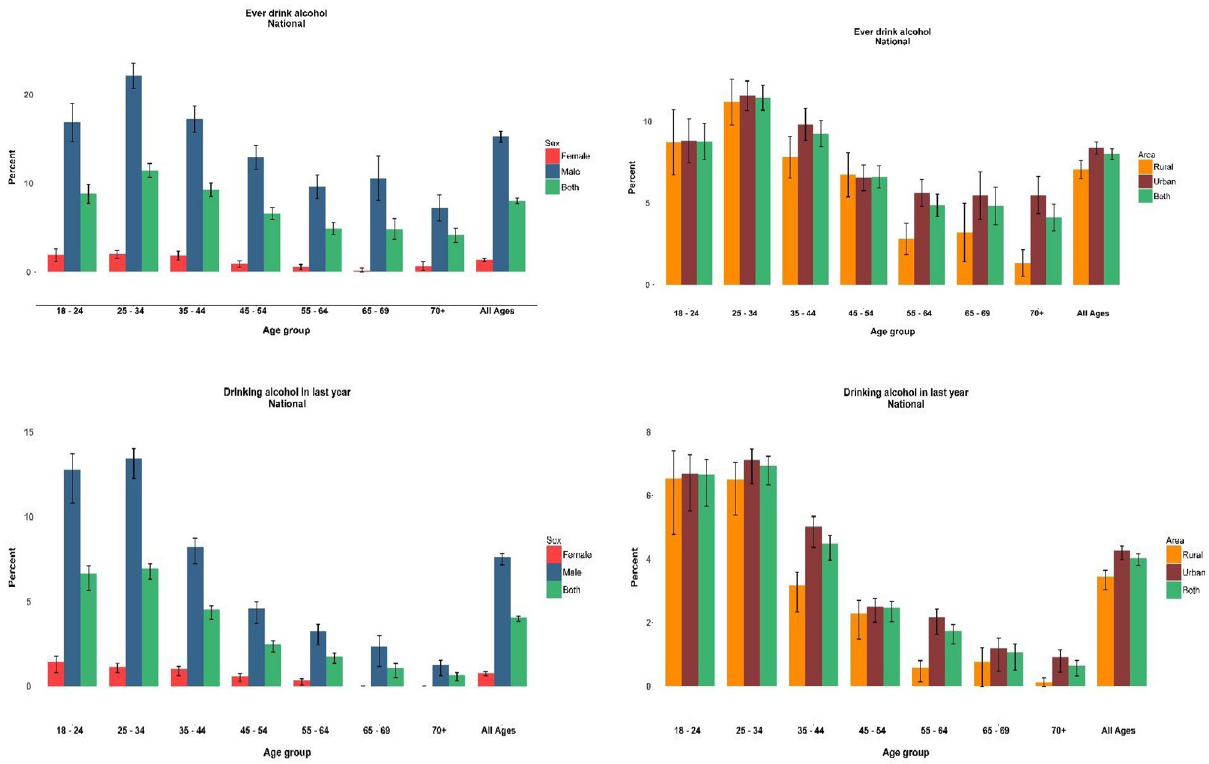
Fig 1. Distribution of alcohol drinking among age group by sex and residential